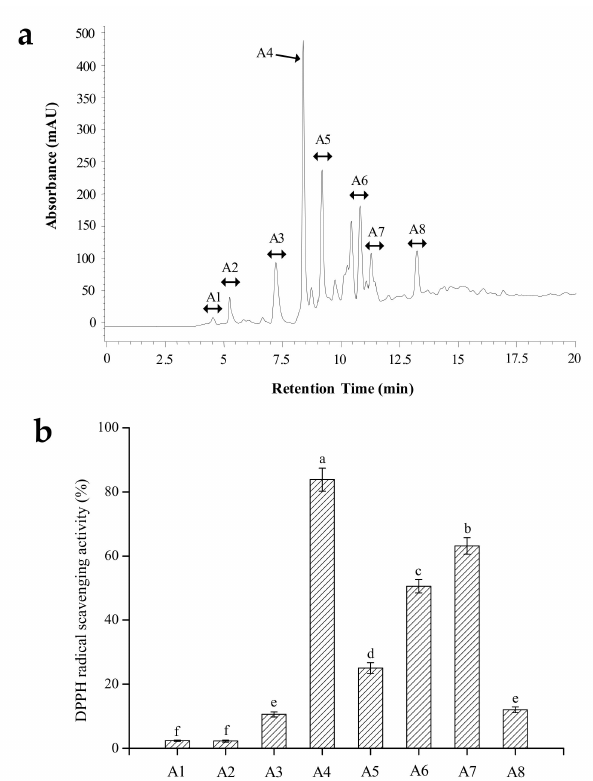
Figure 2. ( a ) Reverse-phase high-performance liquid chromatography (RP-HPLC) separation of the fraction A obtained after gel filtration chromatography; ( b ) DPPH scavenging ability of each fraction (samples at 0.5 mg / mL). The columns having the same letter are not significantly di ff erent ( p >